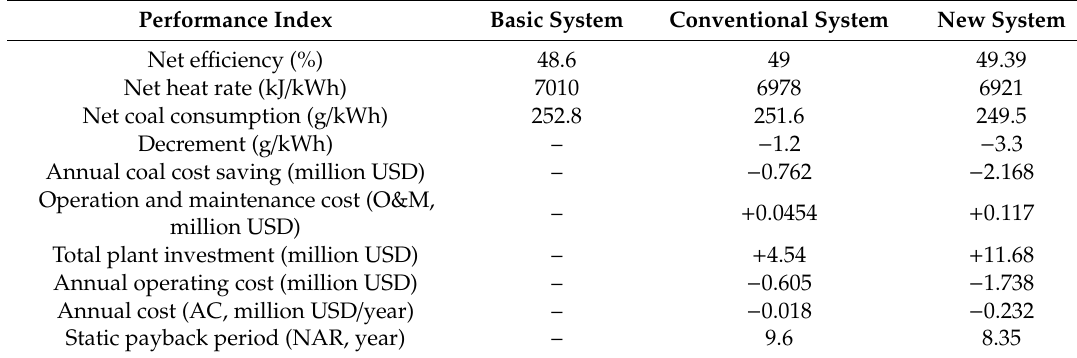
Table 6. Techno-economic performance of each